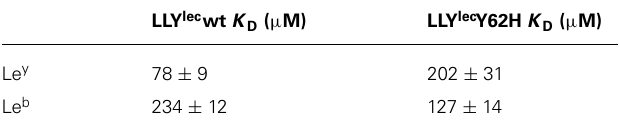
Table 2 | Crystallographic data processing and refinement statistics for LLY lec wt and LLY lec Y62H crystal structures in complex with Le y and Le b